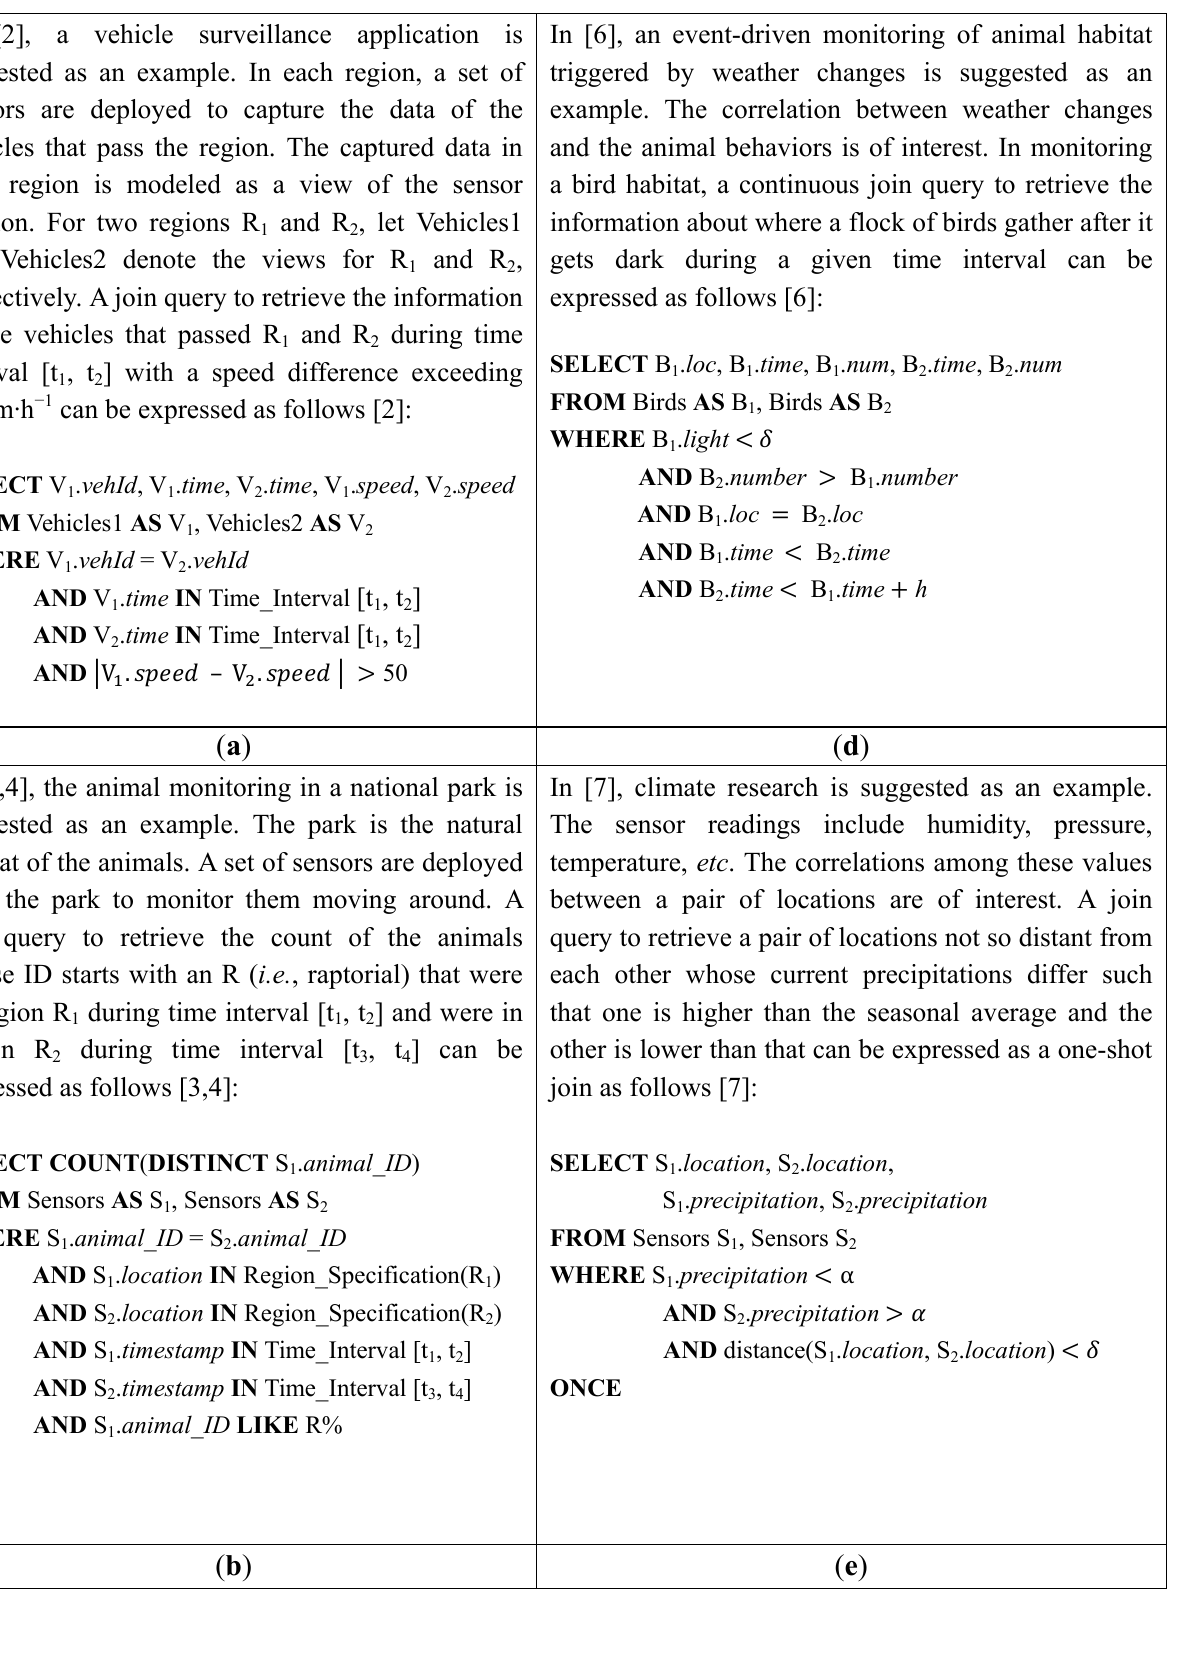
Figure 1. More examples of joins in WSN applications suggested in the literature. The examples of join queries in the literature are not shown. Refer to the referenced papers for them. Additional examples based on them in the same applications are